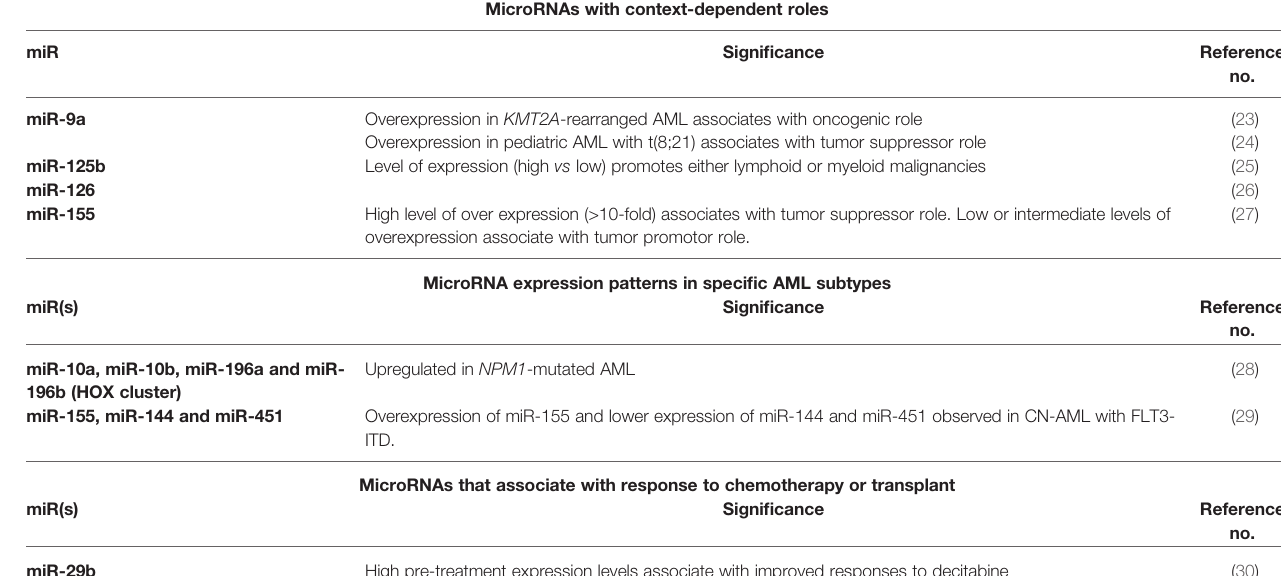
TABLE 1 | Key microRNAs and their roles in AML.